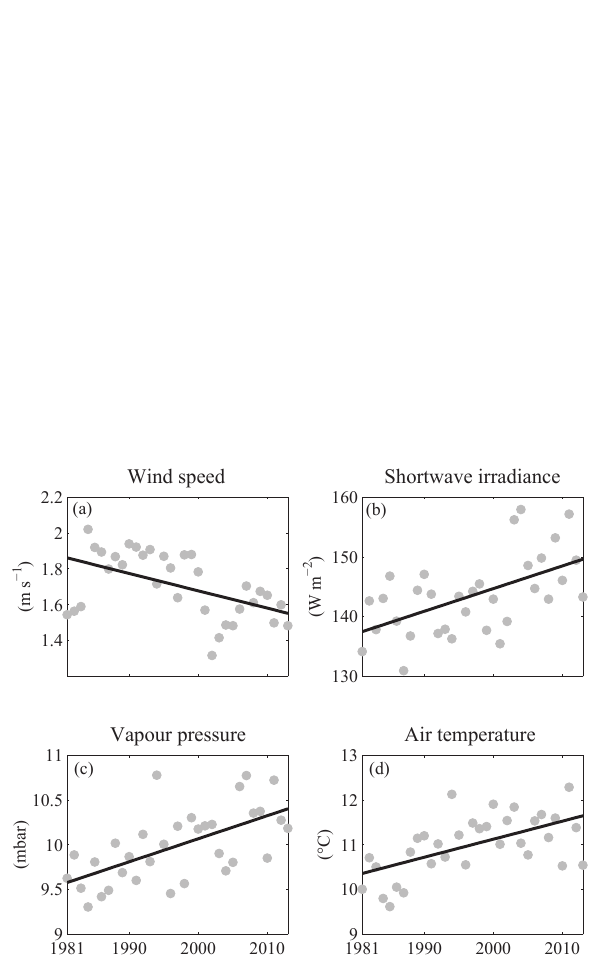
Figure A6. Annual atmospheric forcing (grey dots) of wind speed (a) , shortwave radiation (b) , vapor pressure (c) and Air tem- perature (d) at station no. 8100 (Fig. 2). The black line shows trends (Table